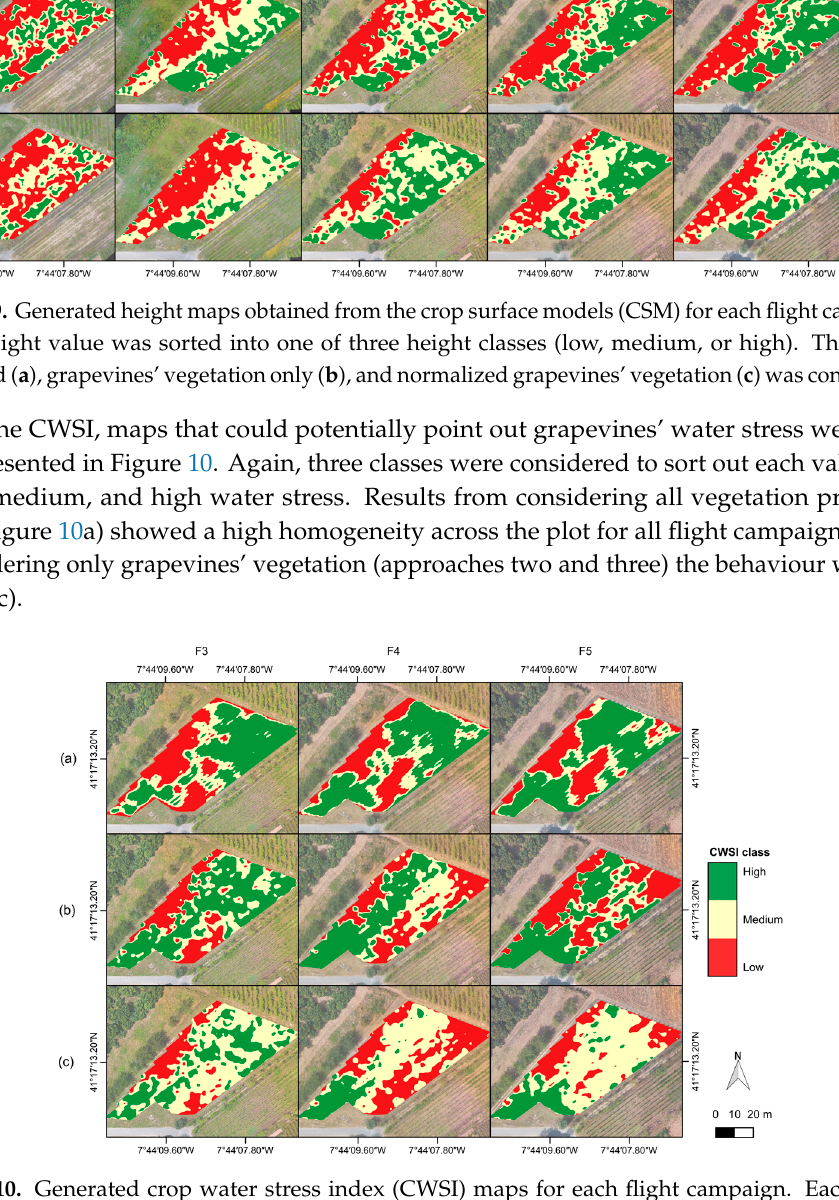
Table 2. Quantitative comparison using the local Moran’s index of the normalized difference vegetation index (NDVI) vigour classes in the three different approaches considered to the crop surface model (CSM) and crop water stress index (CWSI) classes with a p -value < 0.001, for each flight campaign (F#). Vigour map